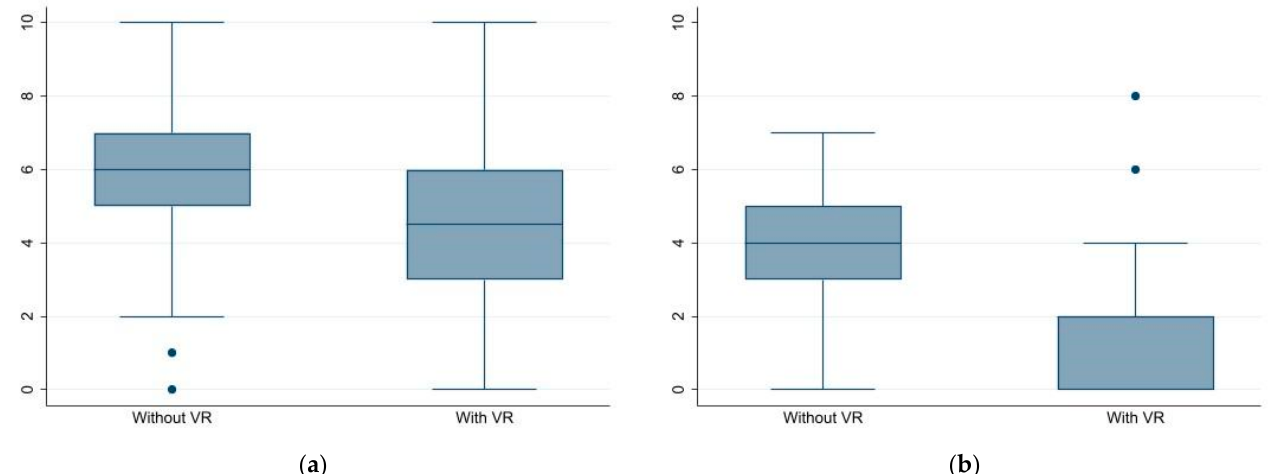
Figure 1. Distress Thermometer ( a ) PRE medication: without VR 6 (IQR 5–7); with VR 4.5 (IQR 3–6); ( b ) POST medication: without VR 4 (IQR 3–5); with VR 2 (IQR 0–2).